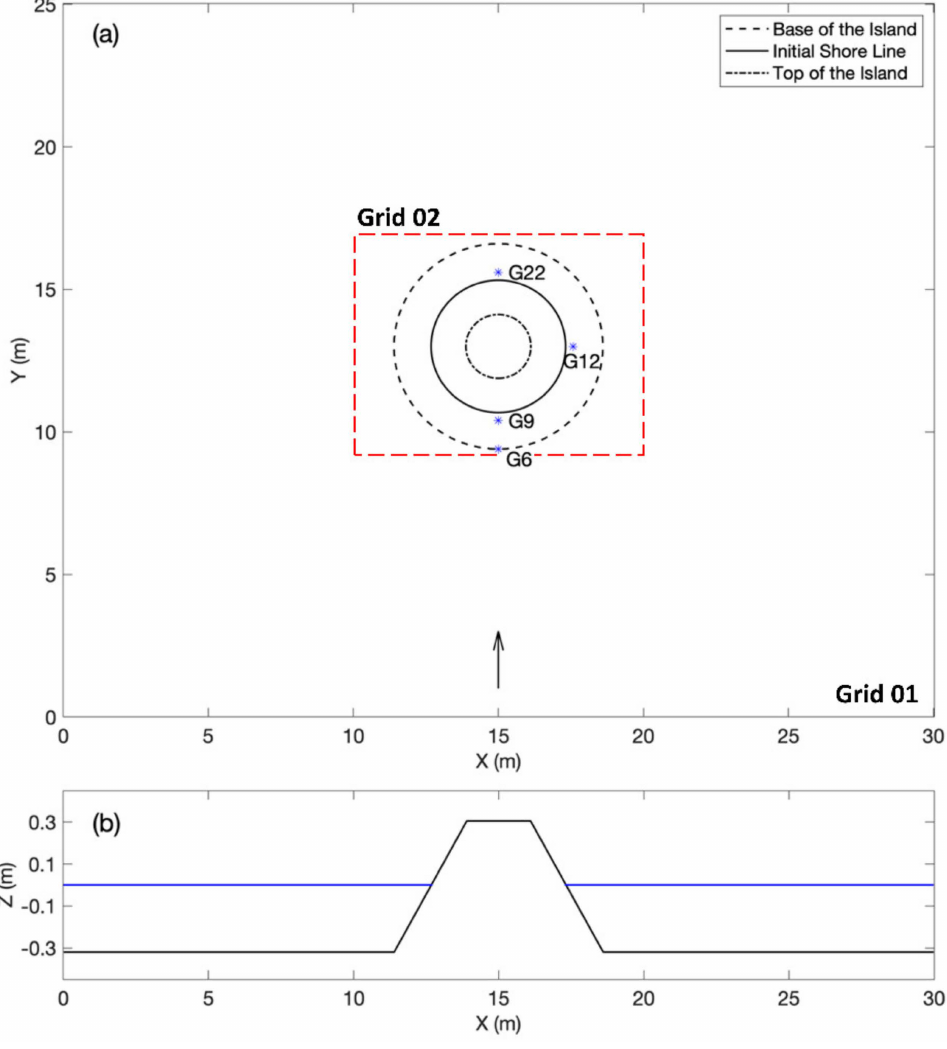
Figure 4. ( a ) Top view of the wave basin and the circular island. The blue asterisks indicate the locations of the wave gauges. The black arrow implies the incident wave direction. The dashed red line shows the domain of Grid 02. ( b ) Side view of the circular island on the x - z plane along the centerline of the circular island. The blue line indicates the still water surface. Table 1. Wave gauge locations around the circular